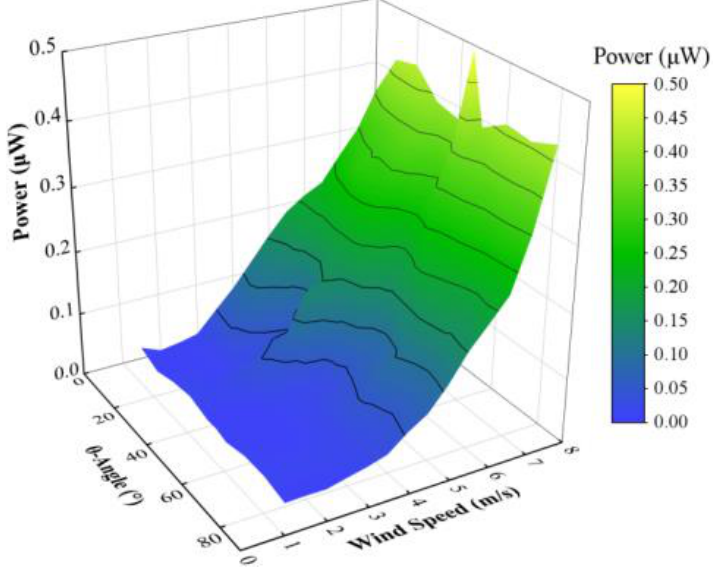
Figure 7. Energy harvesting capability of the harvester with a square-section cylinder.